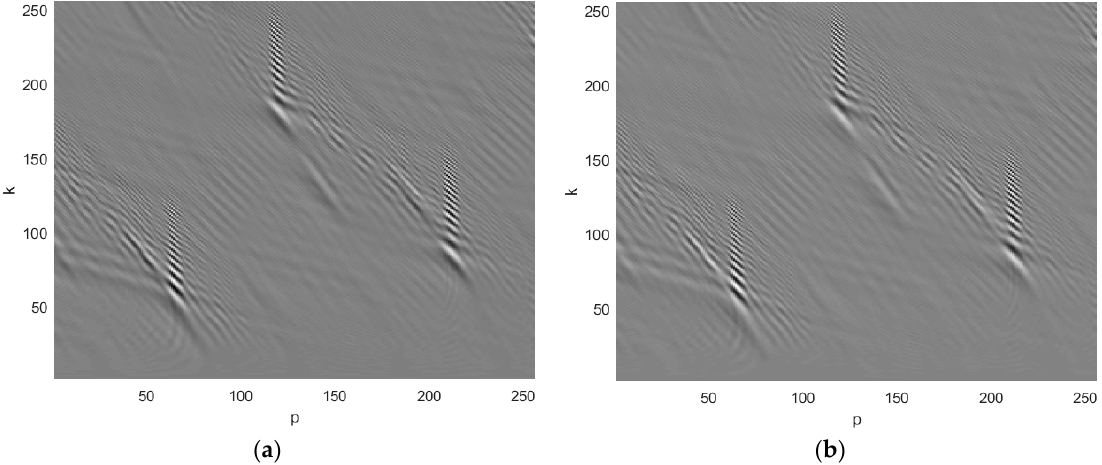
Figure 4. The quadrature components of the demodulated complex SAR signal, the real part ( a ) and imaginary part ( b ).